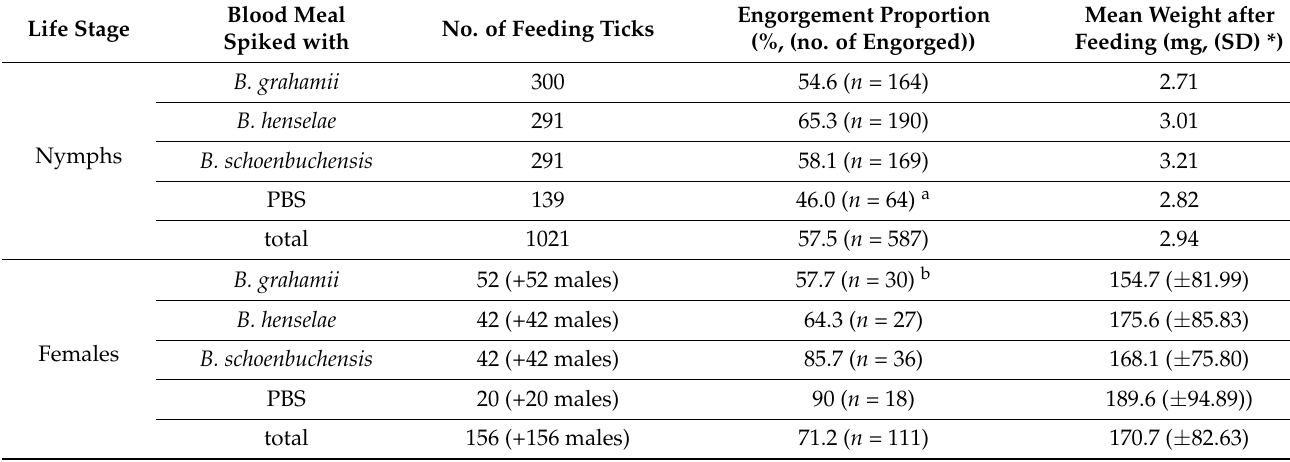
Table 1. Number of Ixodes ricinus ticks used in the artificial feeding experiment fed on blood spiked with different Bartonella species and PBS (negative control groups), their engorgement rates, and mean